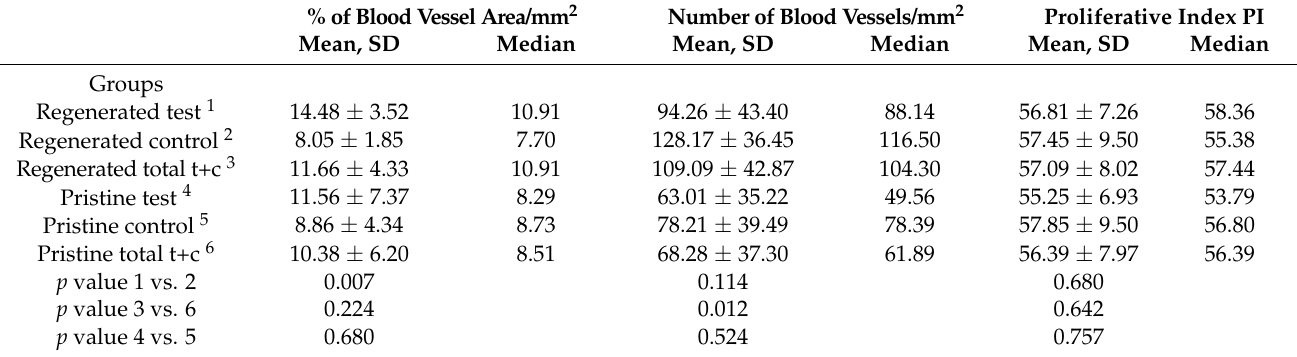
Table 1. Data for blood vessel area/number and cell proliferative index (PI).